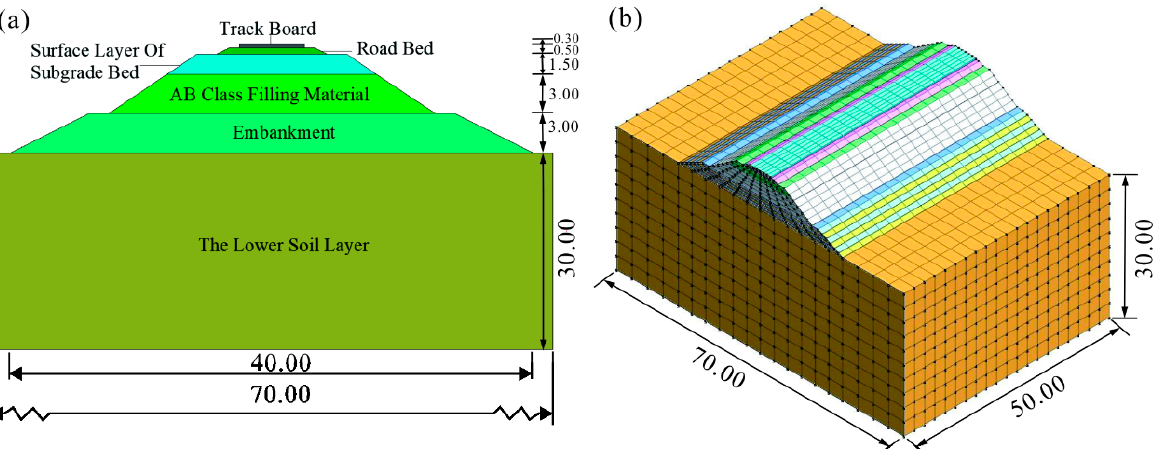
Figure 9. Model diagram of high-speed railway subgrade. ( a ) Schematic diagram of the standard section of subgrade (unit: m); ( b ) 3D model of high-speed railway subgrade (unit: m). Polymers 2021 , 13 , x FOR PEER REVIEW